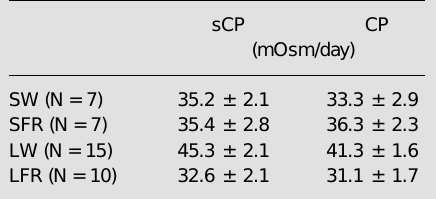
Table 4 - Comparison of osmolar excretion (mOsm/day) during the clinical period (CP; aver- age of values obtained on days 5 to 7) and the subclinical period (sCP) in septal-lesioned tumor- bearing (LW; N = 15), sham-operated tumor-bear- ing (SW; N = 7), sham-operated food-restricted (SFR; N = 7) and septal-lesioned food-restricted (LFR; N = 10)